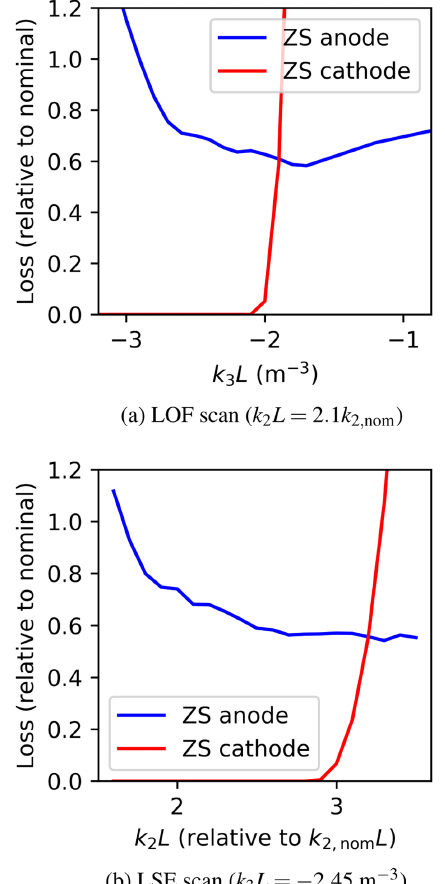
FIG. 13. Simulated beam loss at the ZS as a function of the LSE and LOF strength